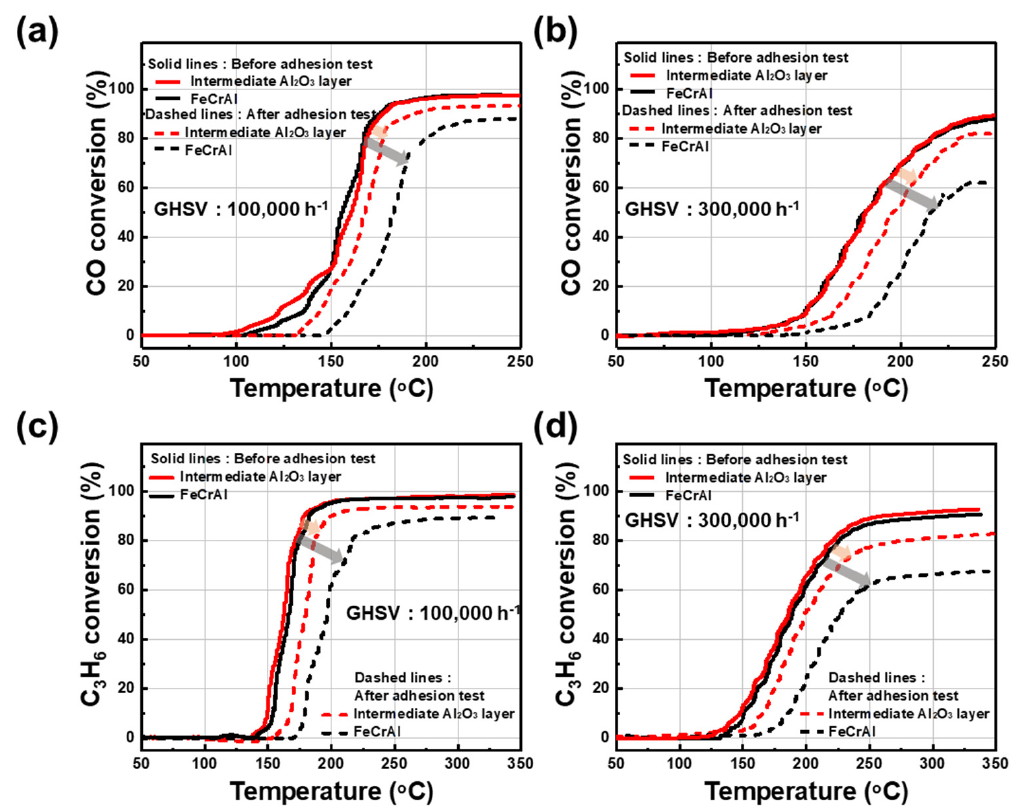
Figure 5. CO ( a , b ) and C 3 H 6 ( c , d ) oxidation performance of the catalysts with and without the γ -Al 2 O 3 intermediate layer on the STS-444 substrate under two GHSV (100,000 and 300,000 h − 1 ) condi- tions.